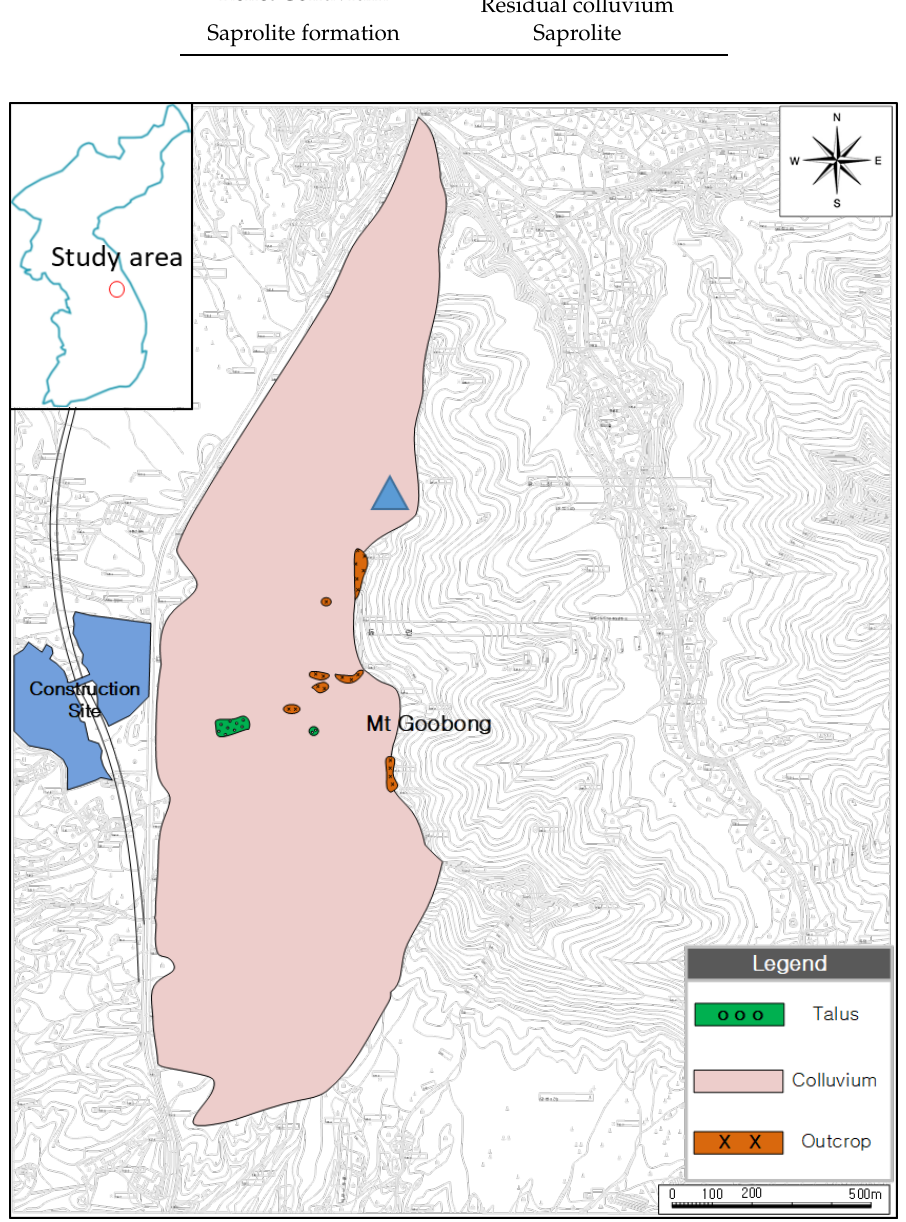
Figure 2. Regolith map in Mt Goobong.